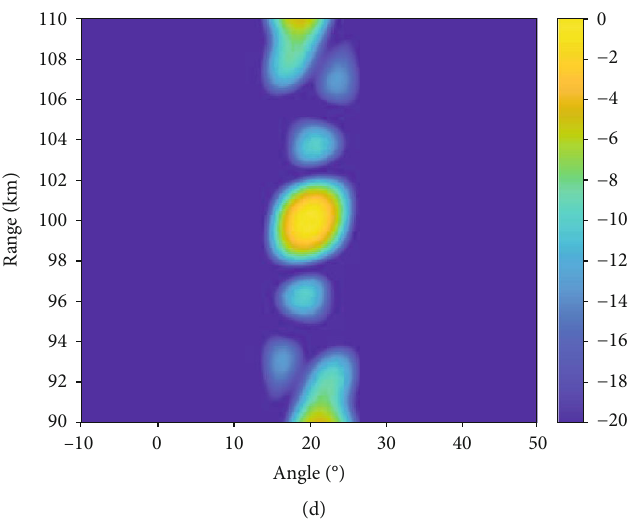
Figure 5: The equivalent transmit beampatterns at the receiver: (a) the beampattern of log_FDA; (b) the beampattern of Ham_FDA; (c) the beampattern of HL_FDA; (d) the beampattern of AM_FDA.